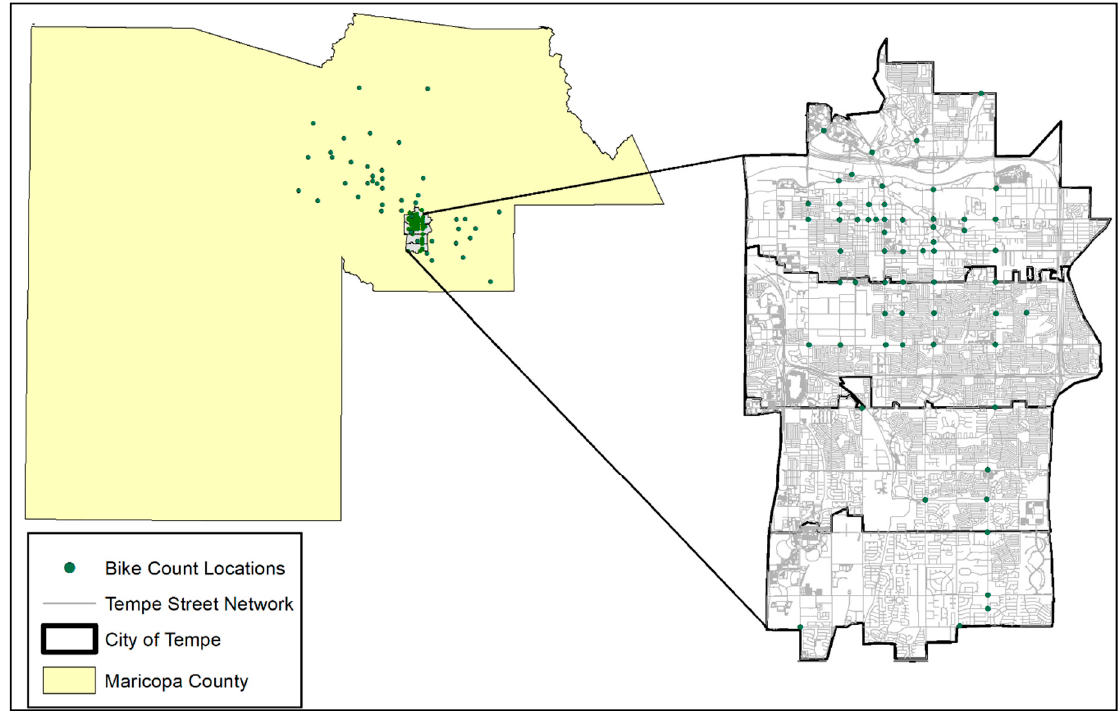
Figure 1. Study area in Maricopa County, AZ, USA.